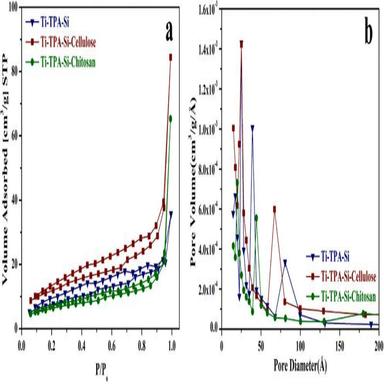
(a) Nitrogen adsorption-desorption BET isotherm curve, (b) Barrett-Joyner-Halenda (BJH) adsorption pore size distribution curve of Ti-TPA-Si, Ti-TPA-Si-C, and Ti-TPA-Si-CS.